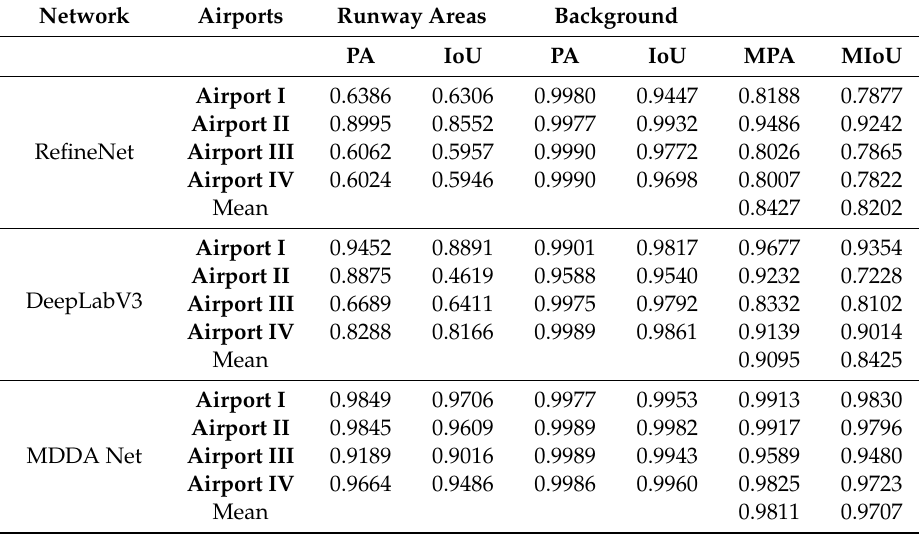
Table 1. The extraction accuracy for airports by di ff erent